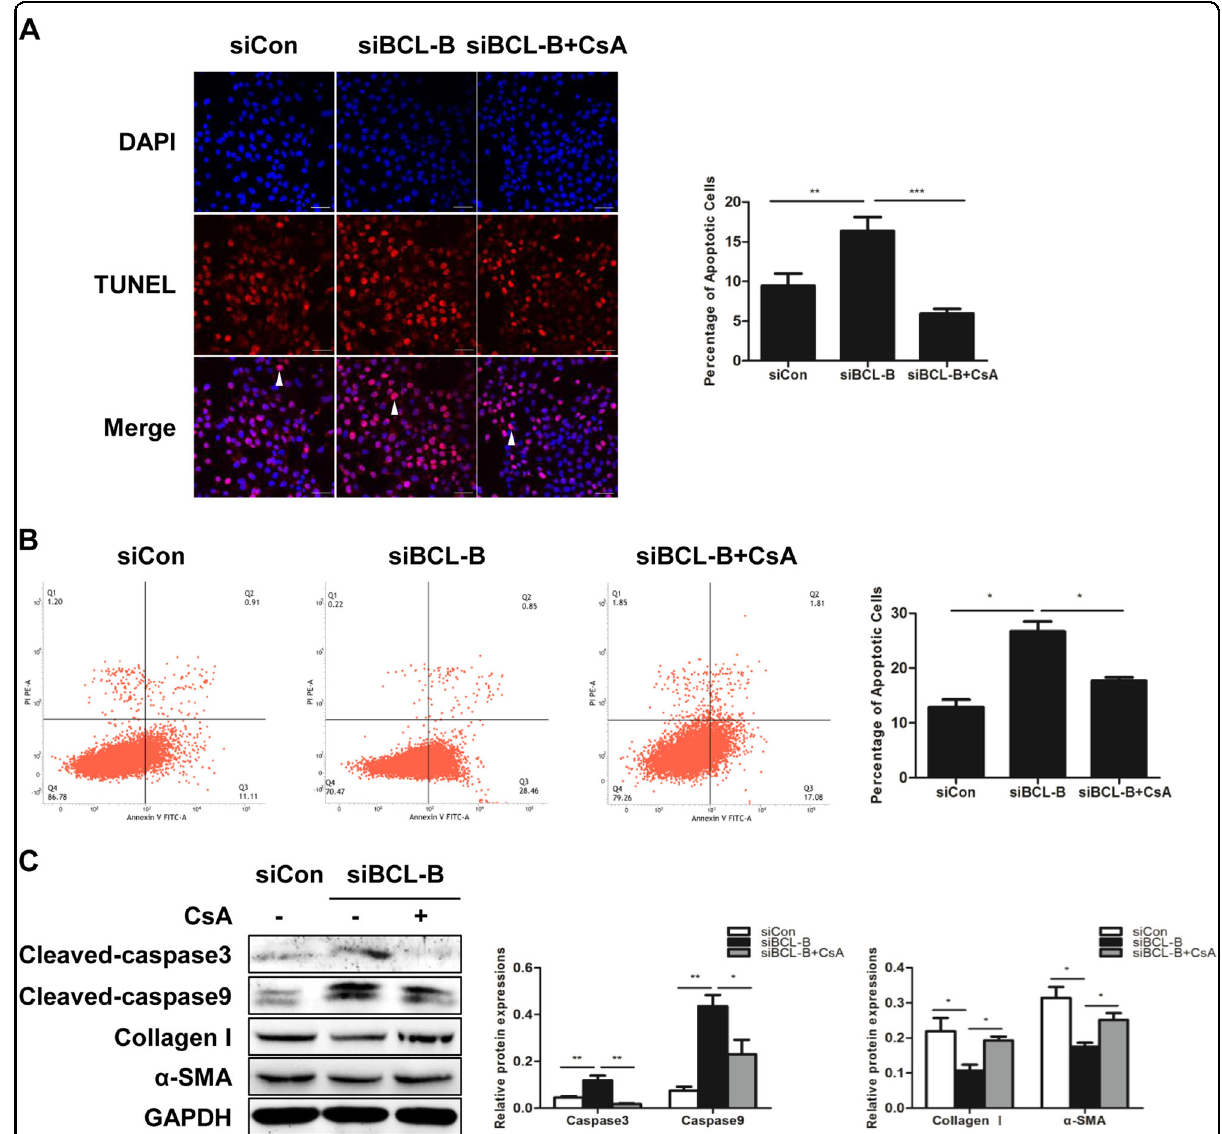
Fig. 6 BCL-B inhibits apoptosis by suppressing mitophagy. a TUNEL staining of LX2 cells from the indicated groups; scale bar, 25 μ m. Bar graph represents the mean ± SEM. ** P < 0.01 and *** P < 0.001 vs. the indicated groups. b Annexin V-FITC/PI double-staining and fl ow cytometry analysis of LX2 cells. Bar graph represents the mean ± SEM. * P < 0.05 vs. the indicated groups. c Representative western blots of cleaved caspase3, cleaved caspase9, collagen I and α -SMA in LX2 cells. Bar graph represents the mean ± SEM of three different experiments. * P < 0.05 and ** P < 0.01 vs. the indicated